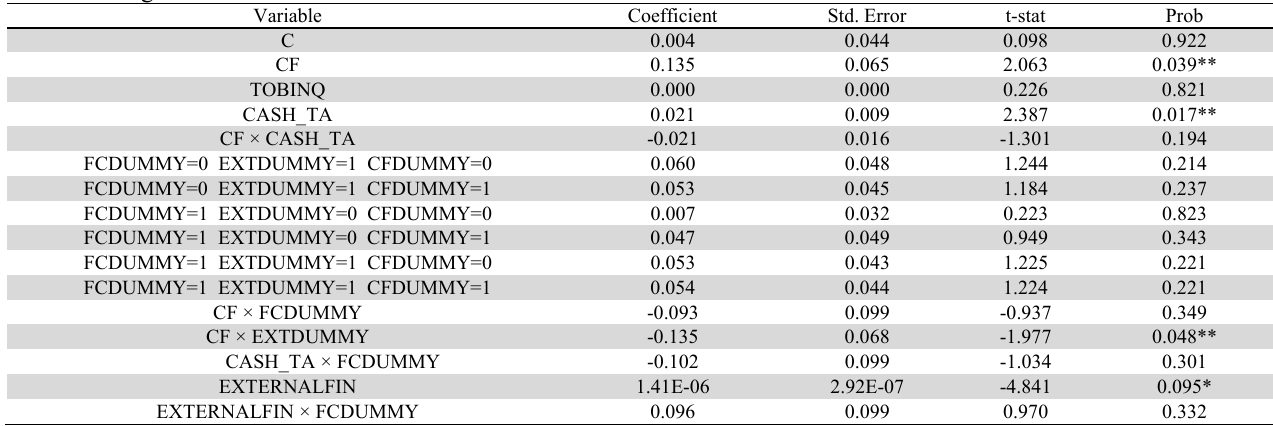
Results of Regression Panel Data of FEM